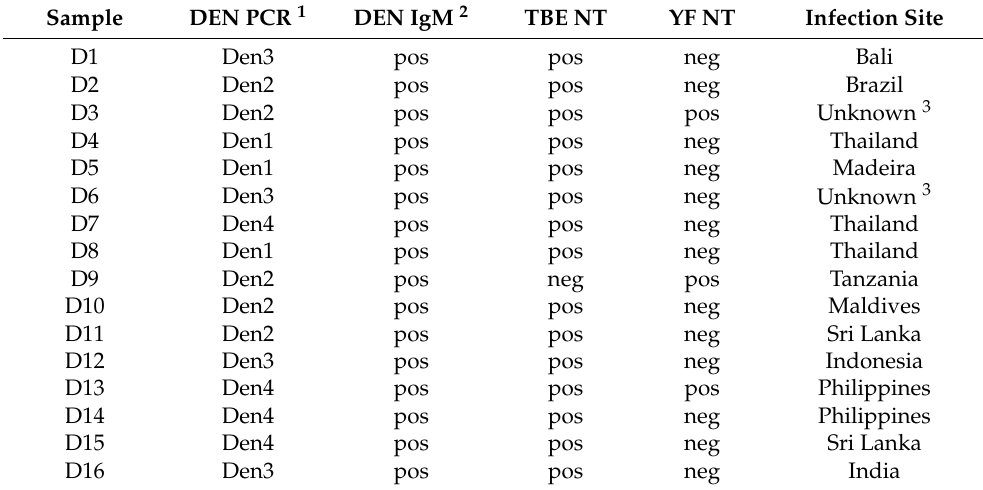
Table 4. Characteristics of dengue serum samples obtained from travelers who returned to Austria from dengue-endemic regions, 2009–2017, as determined by routine diagnosis.